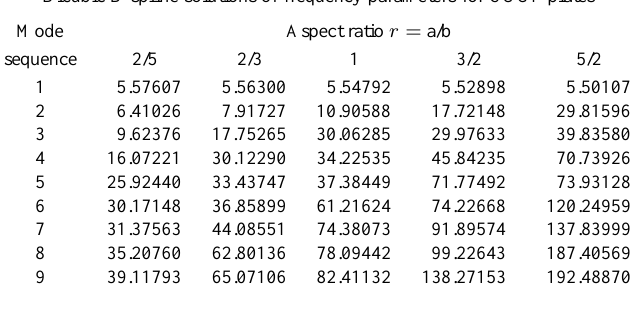
Table 12 Bicubic B-spline solutions of frequency parameters for CGGF plates